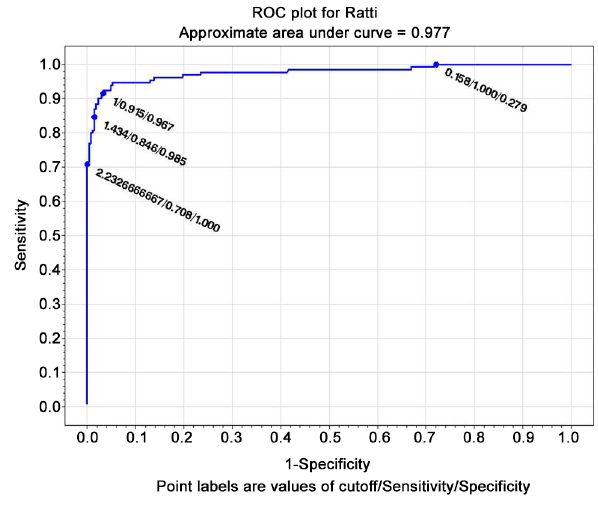
Figure 1. ROC curve for IVD ELISA (composite reference standard).